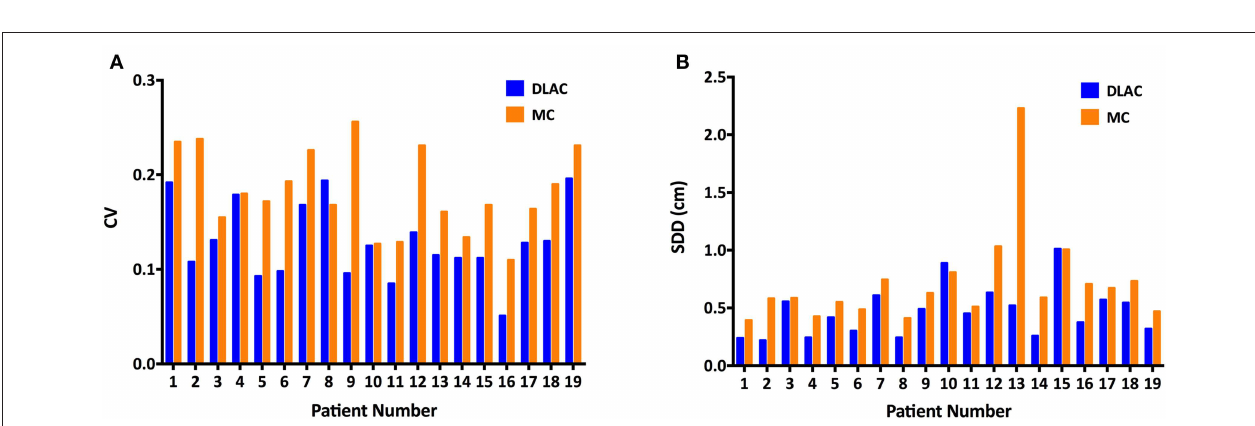
FIGURE 3 | (A) Dice coefficient of the contours with a DLAC (blue boxes) and MC (yellow boxes) and (B) Mean distance to agreement (MDTA) of the contours with a DLAC (blue boxes) and MC (yellow boxes), compared with the GT contour for each junior radiation oncologist with whiskers from the 5–95th percentiles. DLAC, deep learning-assisted contour; MC, manual contour; GT, ground truth contour.